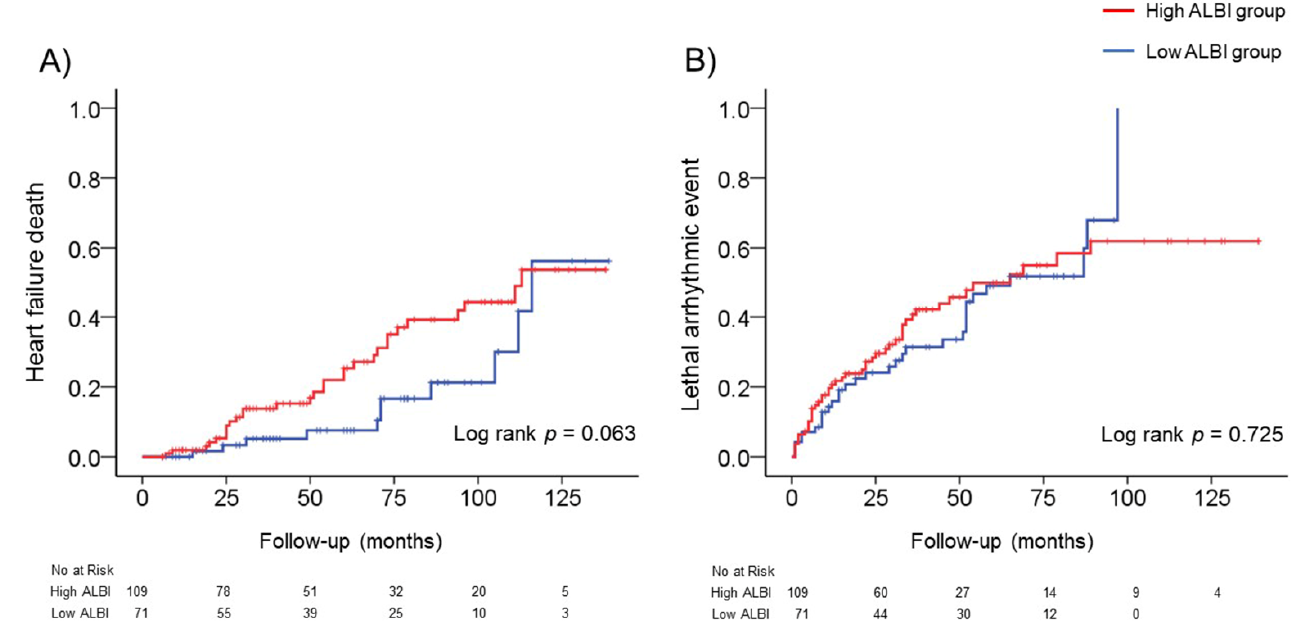
Figure 1. The incidence of adverse events (heart failure death or lethal arrhythmic event) in the High and Low ALBI groups. ( A ) The cumulative incidence curve of heart failure death with a log rank test between the High and Low ALBI groups. ( B ) The cumulative incidence curve of lethal arrhythmic events with a log rank test between the High and Low ALBI groups.